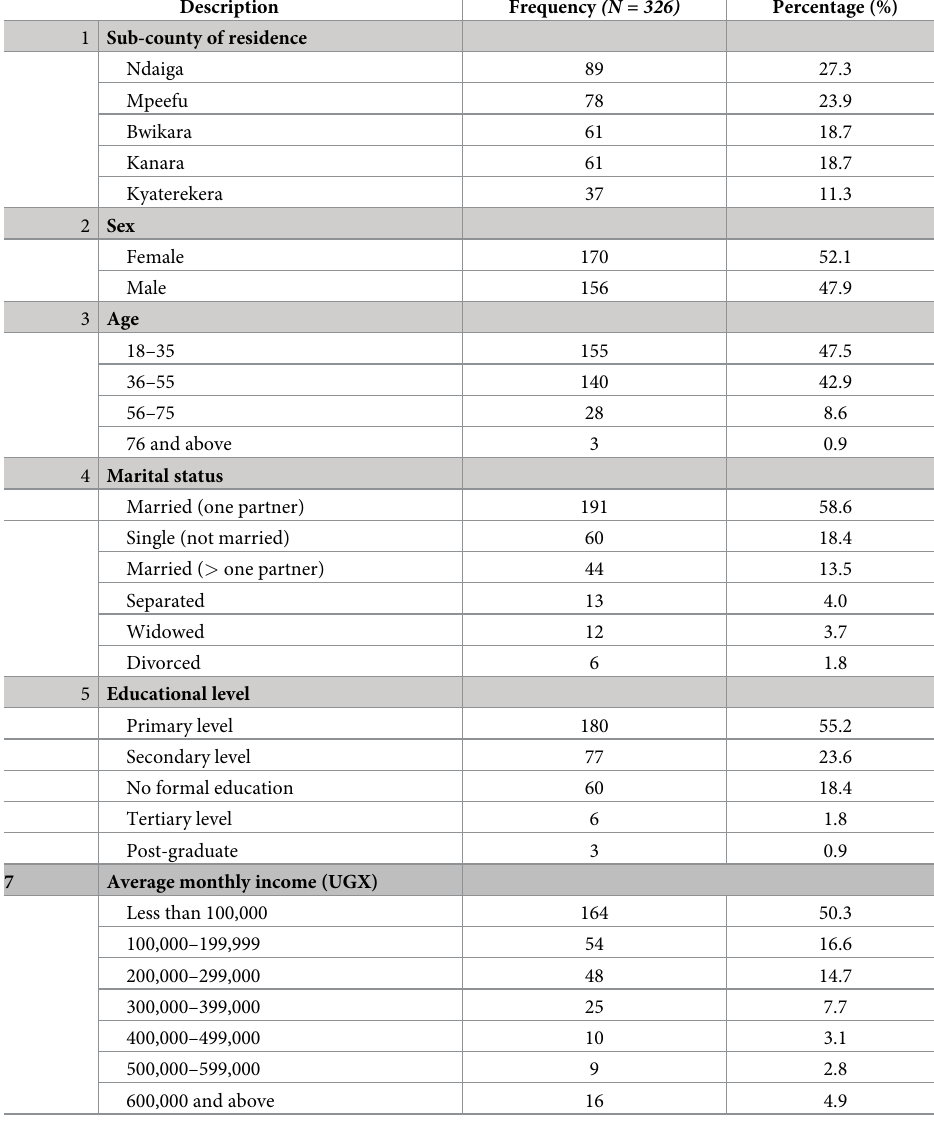
Table 1. Sociodemographic characteristics of the